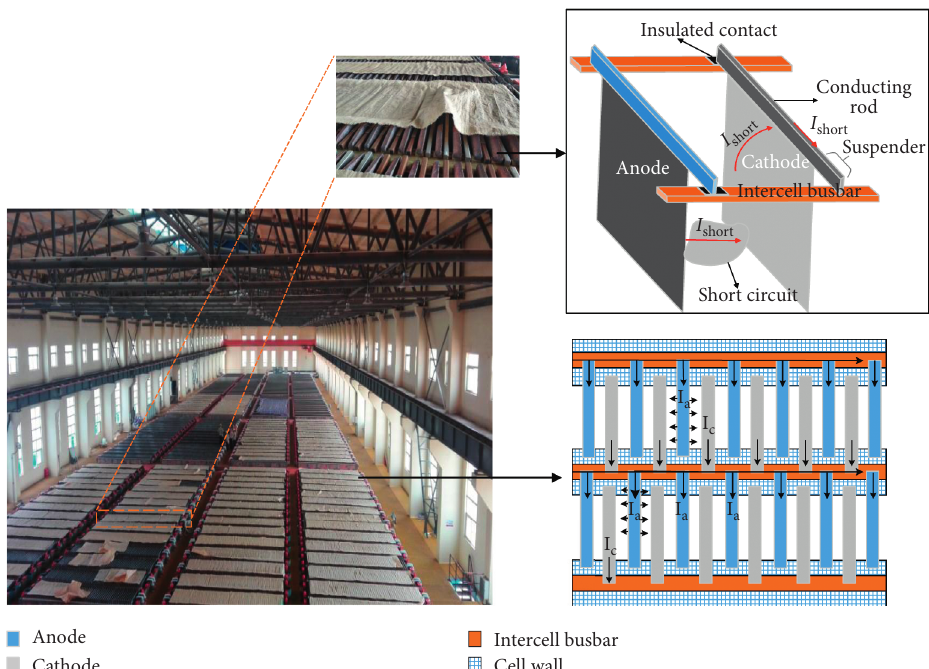
Figure 1: Overhead view of electrolytic cells and electric model superimposed over a physical diagram of the electrolytic refining process.